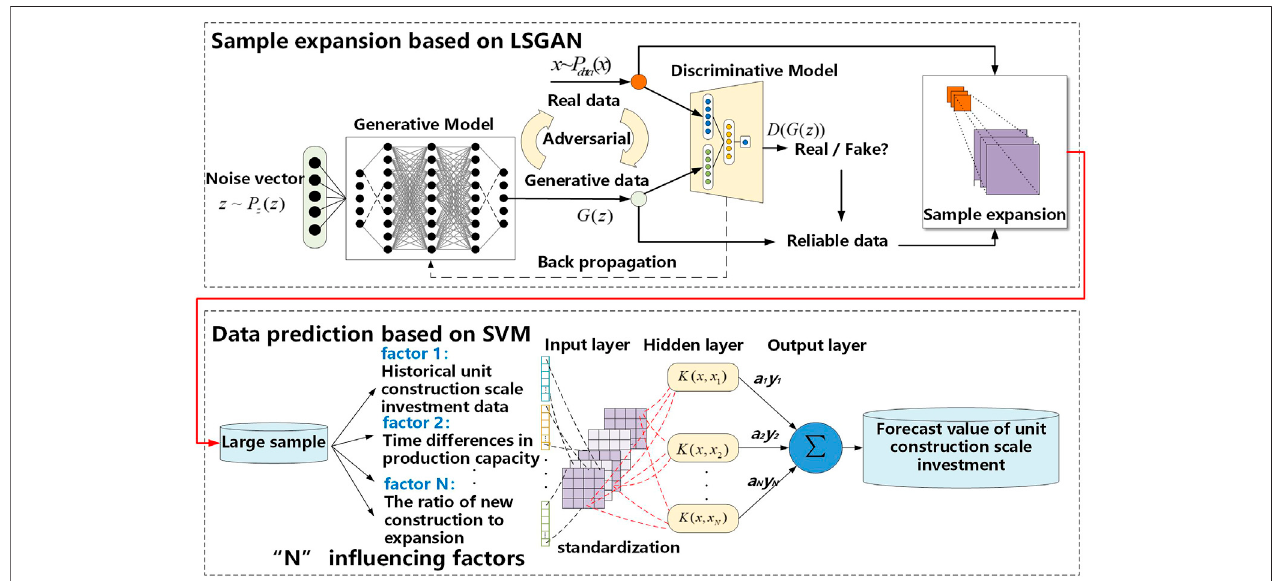
FIGURE 1 | Forecasting model of the amount of unit investment for infrastructure